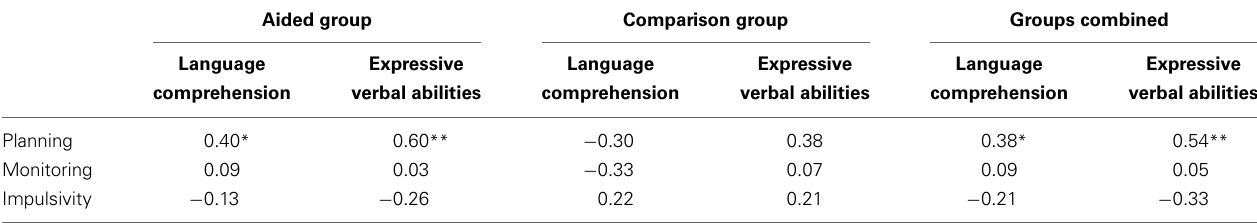
Table 8 | Correlation between executive functions and language comprehension and expressive language